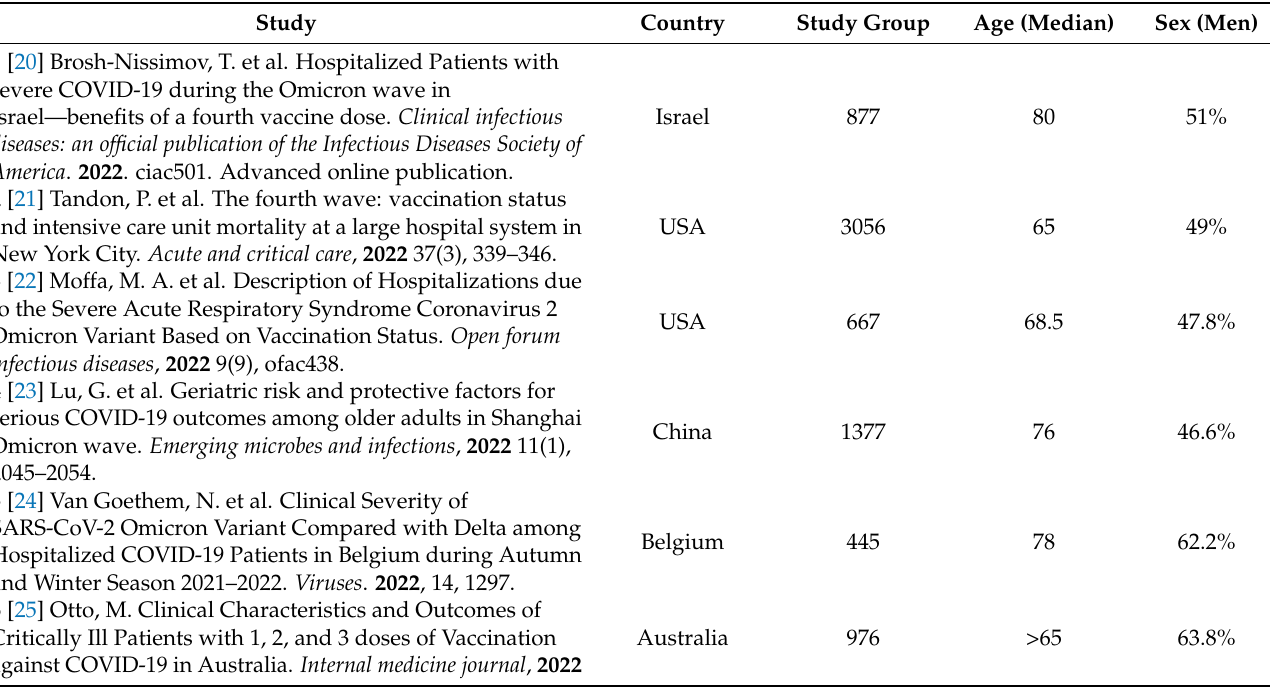
Table 1. Demographic characteristics of studies.